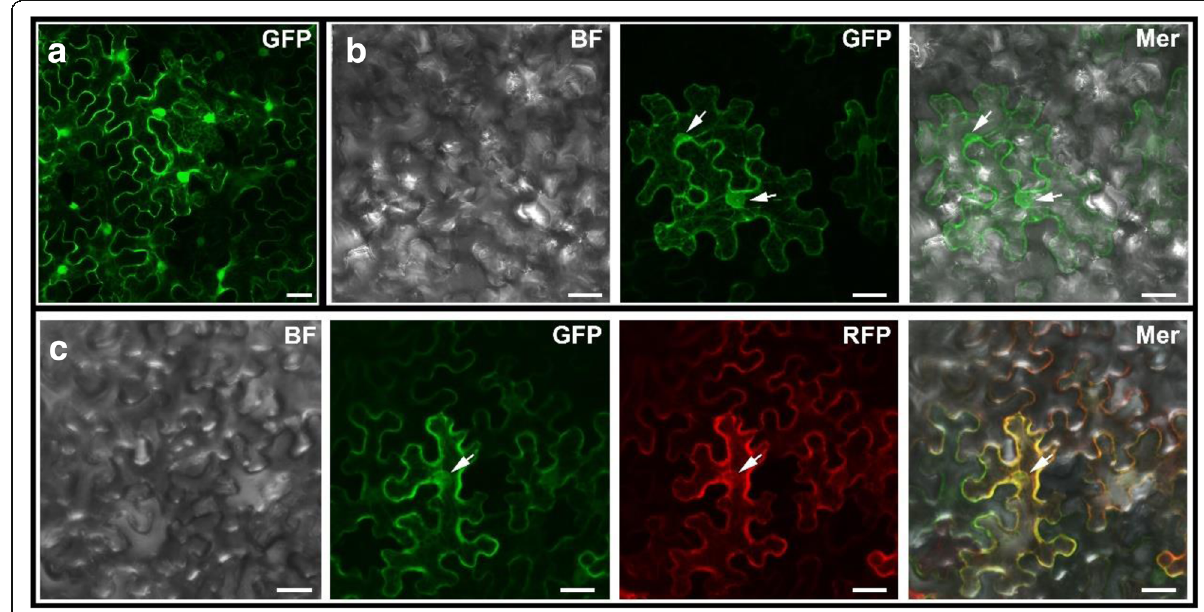
Fig. 6 Subcellular Localization of OsLAP6/OsPKS1 in tobacco leaf epidermal cells. Confocal images of tobacco leaf epidermal cells after 72 h of infection were shown. a Transient expression of control, showing that the expression of the GFP protein was distributed throughout the cell. b Transient expression of OsLAP6/OsPKS1-GFP, showing that OsLAP6/OsPKS1 may localize to the ER-like structures. c Co-expression of OsLAP6/ OsPKS1-GFP and ER-marker, showing the GFP signals of OsLAP6/OsPKS1-GFP are well merged with the RFP signals of ER-marker. The white arrows indicate the ER-ring. BF, bright field; GFP, green fluorescent protein channel; Mer, merged image of each channel. Scale bars =20 μ